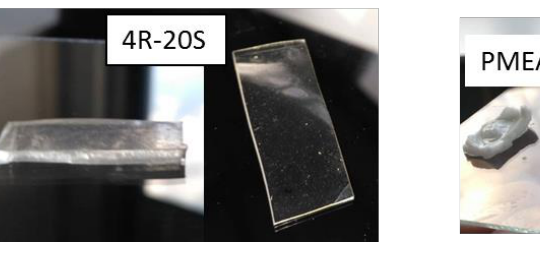
Figure 1. Appearance of selected samples of polyMEA-based materials in dry state (left) and after 1 month of swelling in water